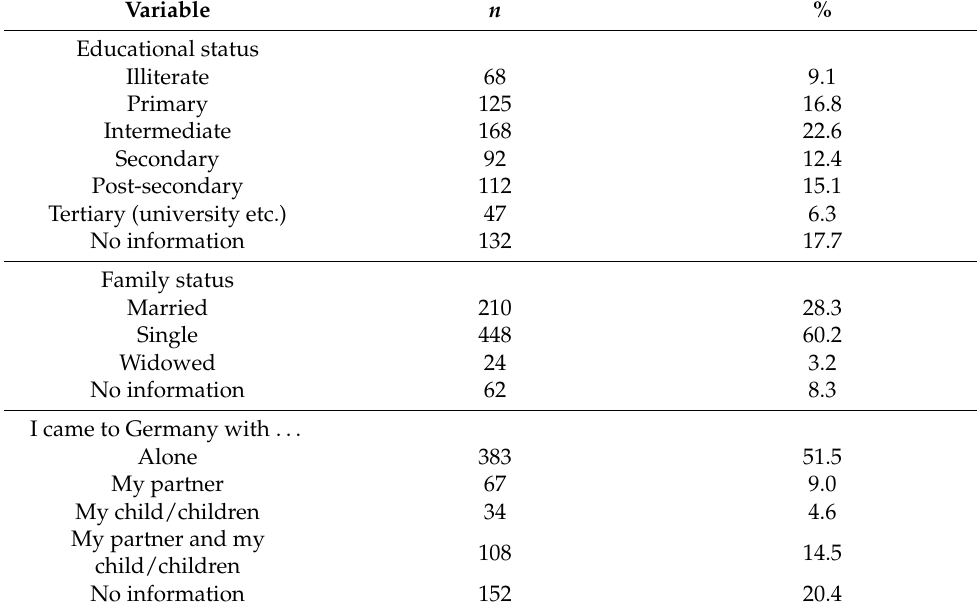
Table 1. Further demographic characteristics of the